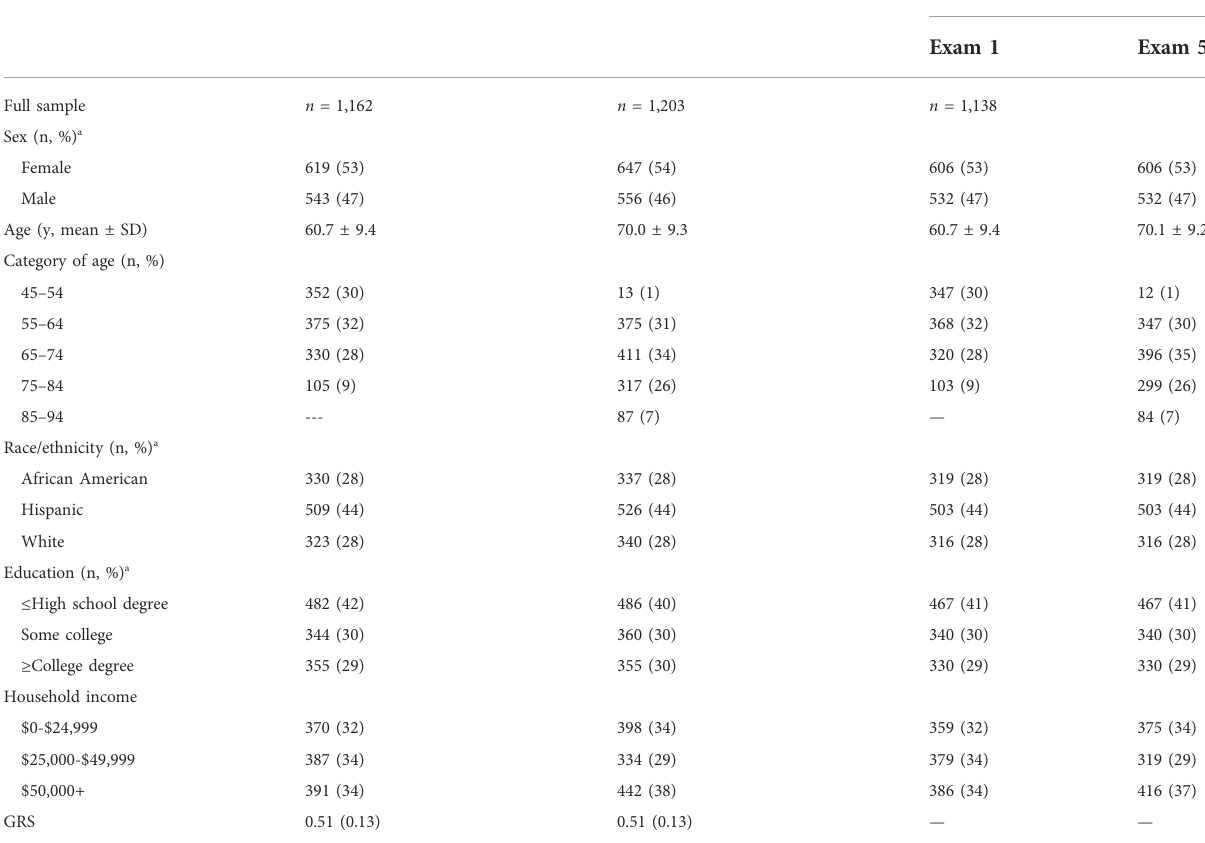
TABLE 1 Characteristics of study participants.